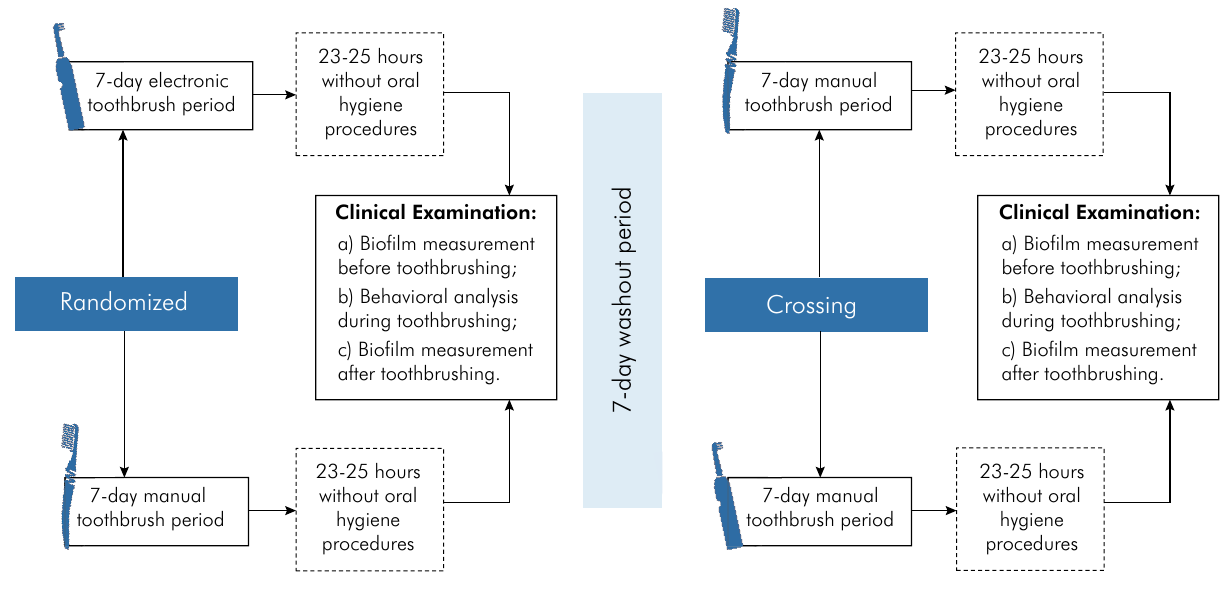
Figure 2. Flow chart of the experimental